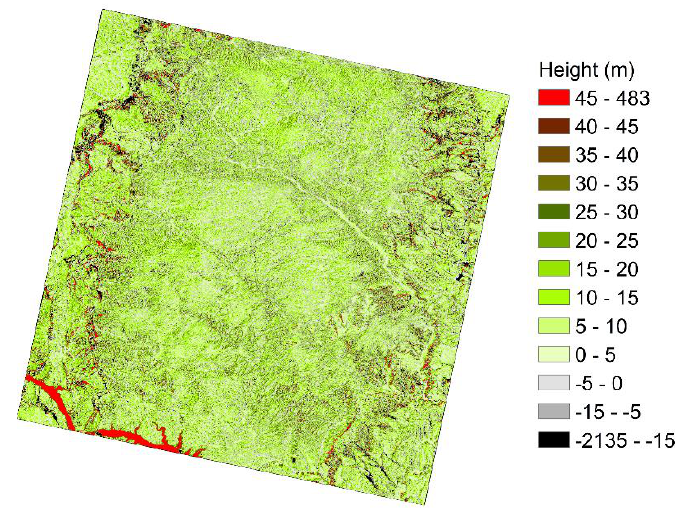
Figure 5. The crude canopy height model (CHM) extracted from the ZY-3 DSM and SRTMGL1.